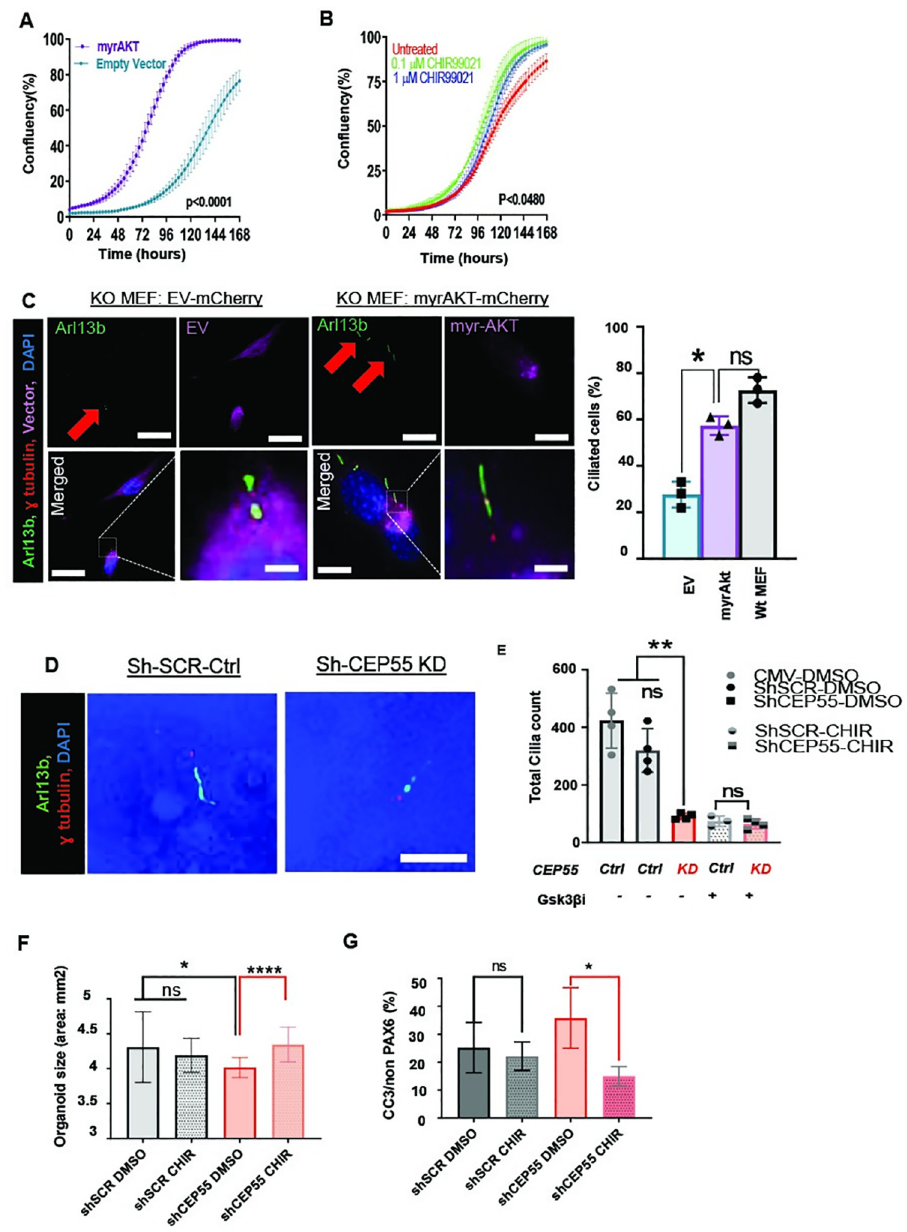
Fig 6. Myr-AKT and downstream effectors can rescue Cep55 loss. Proliferation assay showing the growth of Cep55 -/- (KO) MEF (A) Transiently transfected with EV (turquoise blue) or myr-AKT (purple) and (B) treated with indicated doses of GSK3 β inhibitor, CHIR99021 (untreated: red, 0.1 μ M inhibitor: green, 1 μ M inhibitor: blue). Mean ± SD, the average of 2 biological repeats and 3 independent experiments Student’s t-test, ���� p < 0.0001. (C) Representative images of Cep55 -/- (KO) MEFs reconstituted with EV-mCherry (left) or myrAKT-mCherry (right) immunostained for cilia (Arl13b), basal body ( γ -tubulin) and nuclei (DAPI). The lower panel shows merged images with magnification of the boxed area. Scale = 12 μ m. Left: Percentage of ciliated cells in Cep55 +/+ (Wt) and Cep55 -/- (KO) MEFs transfected with EV or myr-Akt. Mean ± SD, n = 100 cells from 3 independent experiments Student’s t-test, � p < 0.05). (D) Representative image U6 (shSCR Ctrl) and CEP55 KD human brain organoids immunostained for cilia (ARL13b), basal body ( γ -tubulin) and nuclei (DAPI), Scale = 10 μ m. (E-G) Comparison of U6 (shSCR Ctrl) and CEP55 KD untreated (DMSO) and treated with 3 μ M GSK3 β inhibitor, CHIR99021 for (E) Ciliated cell counts, p < 0.0010 (F) The size of organoids (area) p < 0.0380 for control, p < 0.0001 for shCEP55 (G) The percent of cleaved Caspase 3 in PAX6 negative cells, p < 0.5767 for control, p < 0.0104 for shCEP55. Data were measured across two independent experiments. n = 6 organoids. Mean ± SD, one-way ANOVA (Kruskal–Wallis test) performed, �� p < 0.01).